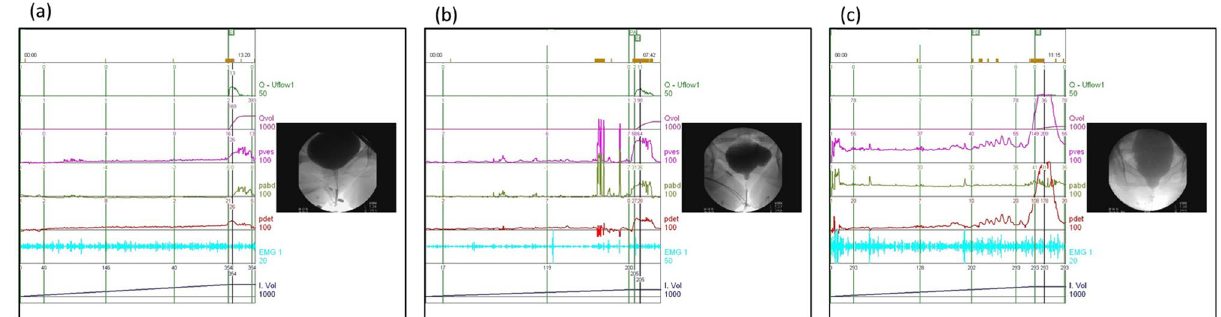
Figure 1. Videourodynamic characteristics of ( a ) Normal, ( b ) DV and ( c ) severe DV